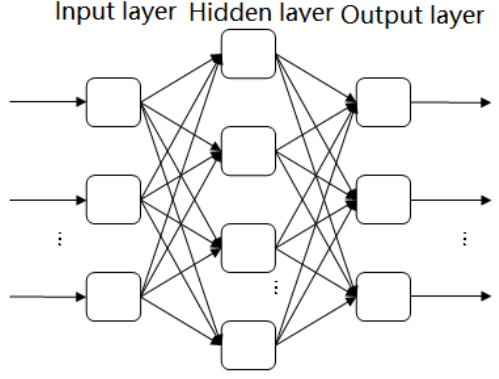
Figure 3. BP neural network structure.